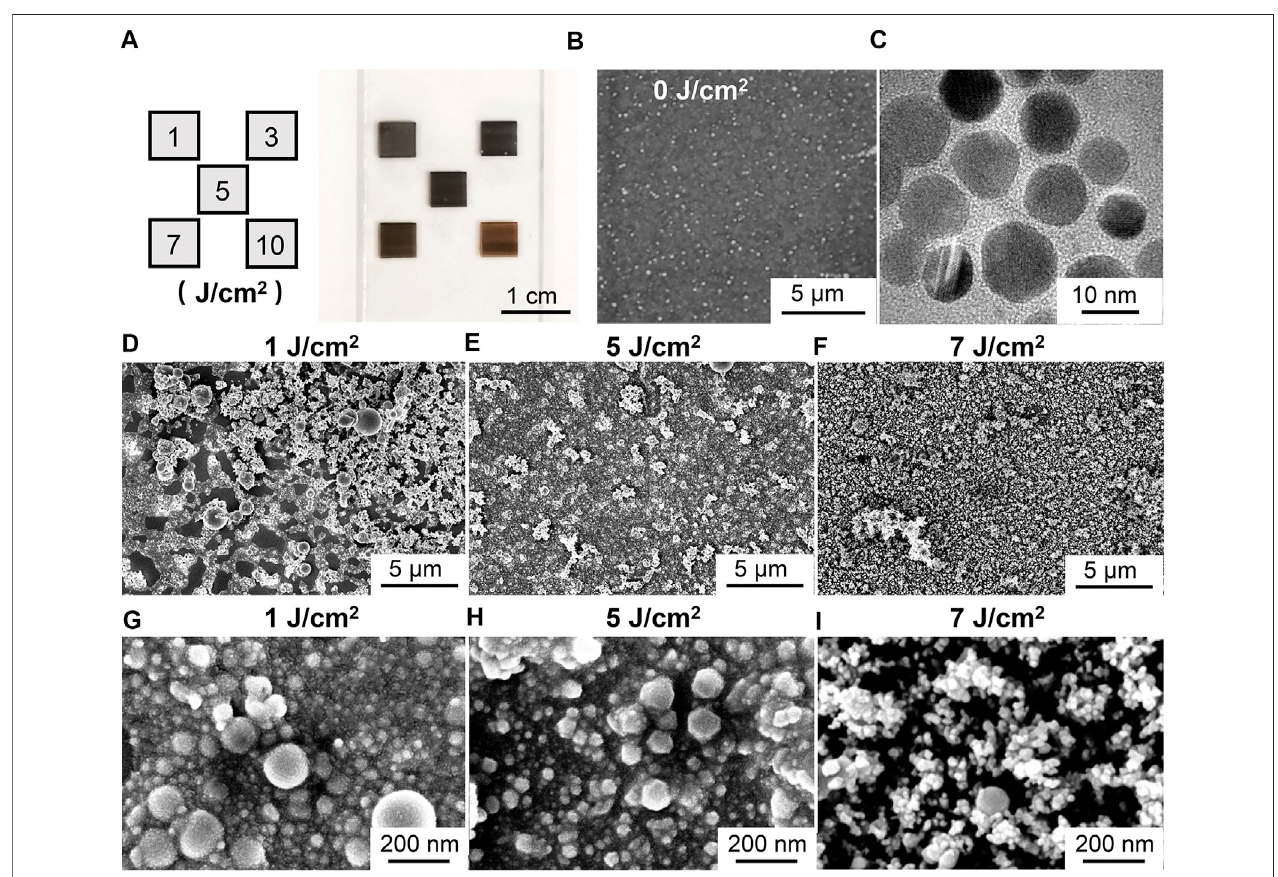
FIGURE 3 | (A) Laser-transfered BMA layers with the laser fl uence of 1, 3, 5, 7, and 10 J/cm 2 . (B) SEM image of the donor fi lm. (C) TEM image of AgNPs. SEM imagesofthe laser-transferred BMA fi lms withthe laser fl uence of (D) 1 J/cm 2 , (E) 5 J/cm 2 , and (F) 7 J/cm 2 . Theenlarged SEM images with thelaser fl uence of (G) 1 J/ cm 2 , (H) 5 J/cm 2 , and (I) 7 J/cm 2